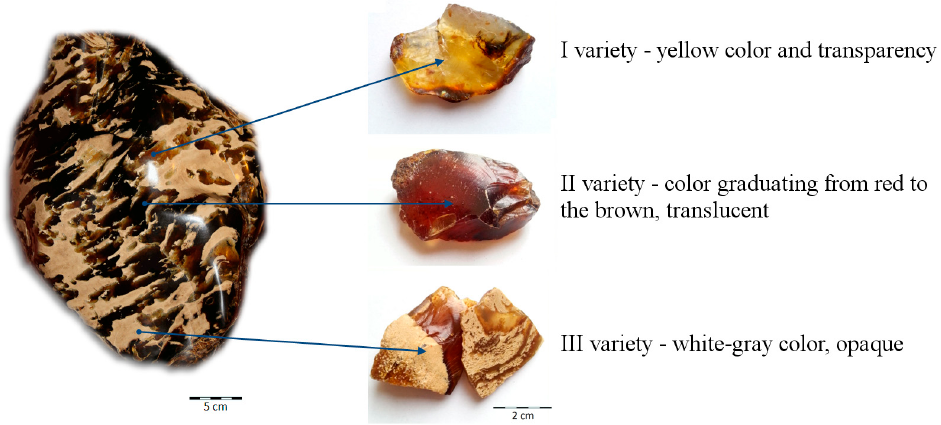
Figure 1. Samples of three varieties of Sumatran resin taken from its aggregate.